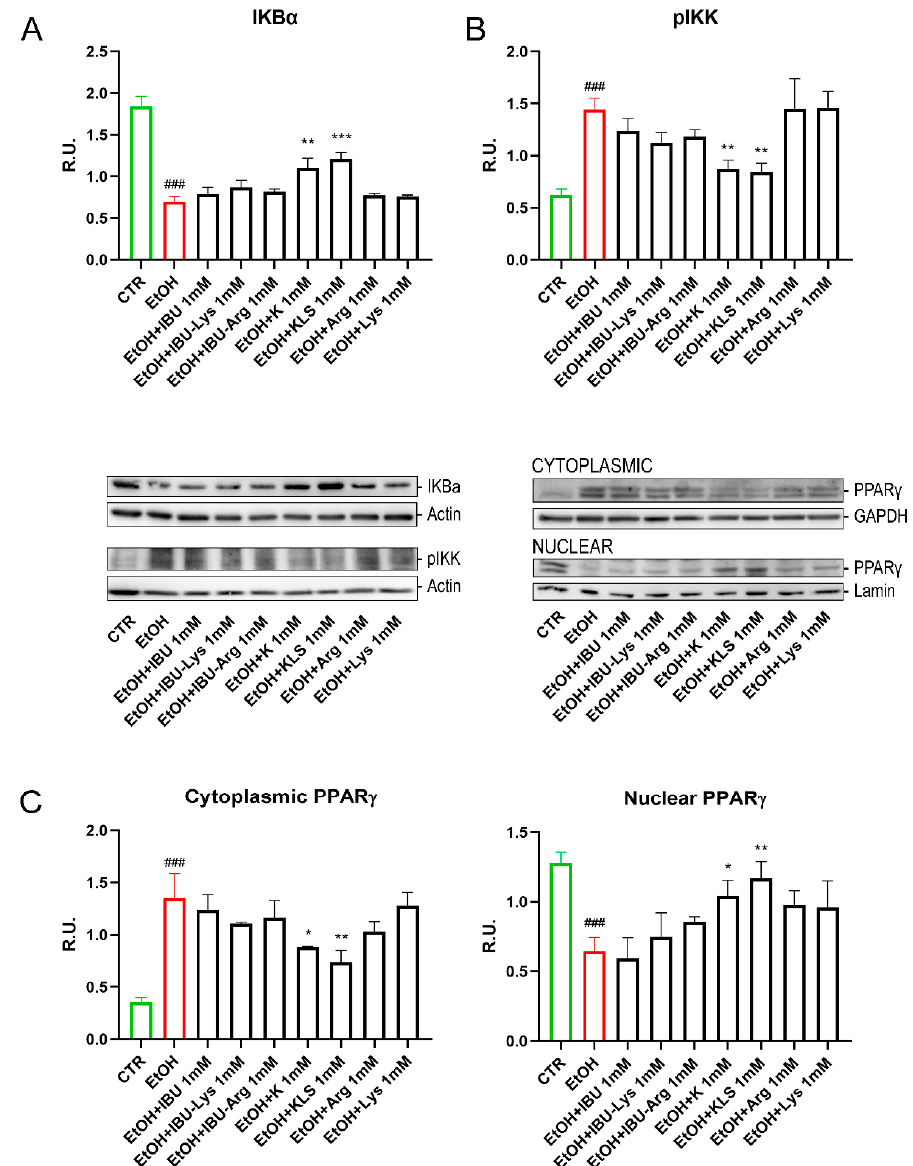
Figure 4. ( A ) WB analysis for IKB α (cytoplasmic and nuclear components) on Caco-2 cells after EtOH (6%, for 24 h), EtOH + IBU, EtOH + IBU-Lys, EtOH + IBU-Arg, EtOH + K, EtOH + KLS, EtOH + Arg, and EtOH + Lys treatments (1 mM) for 72 h. ( B ) WB analysis for the active form of IKK (pIKK) (cytoplasmic and nuclear components) on Caco-2 cells after EtOH (6%, for 24 h), EtOH + IBU, EtOH + IBU-Lys, EtOH + IBU-Arg, EtOH + K, EtOH + KLS, EtOH + Arg, and EtOH + Lys treatments (1 mM) for 72 h. Representative images of WB for IKB α , pIKK and PPAR γ (cytoplasmic and nuclear components) are shown. ( C ) WB analysis for PPAR γ (cytoplasmic and nuclear components) on Caco-2 cells after EtOH (6% for 24 h), EtOH + IBU, EtOH + IBU-Lys, EtOH + IBU-Arg, EtOH + K, EtOH + KLS, EtOH + Arg, and EtOH + Lys treatments at 1 mM for 72 h. Data are mean ± SD of 3 different experiments. One way ANOVA was performed: ***, p < 0.0001; **, p < 0.005; *, p < 0.05; vs. EtOH; ###, p < 0.0001 EtOH vs. CTR.